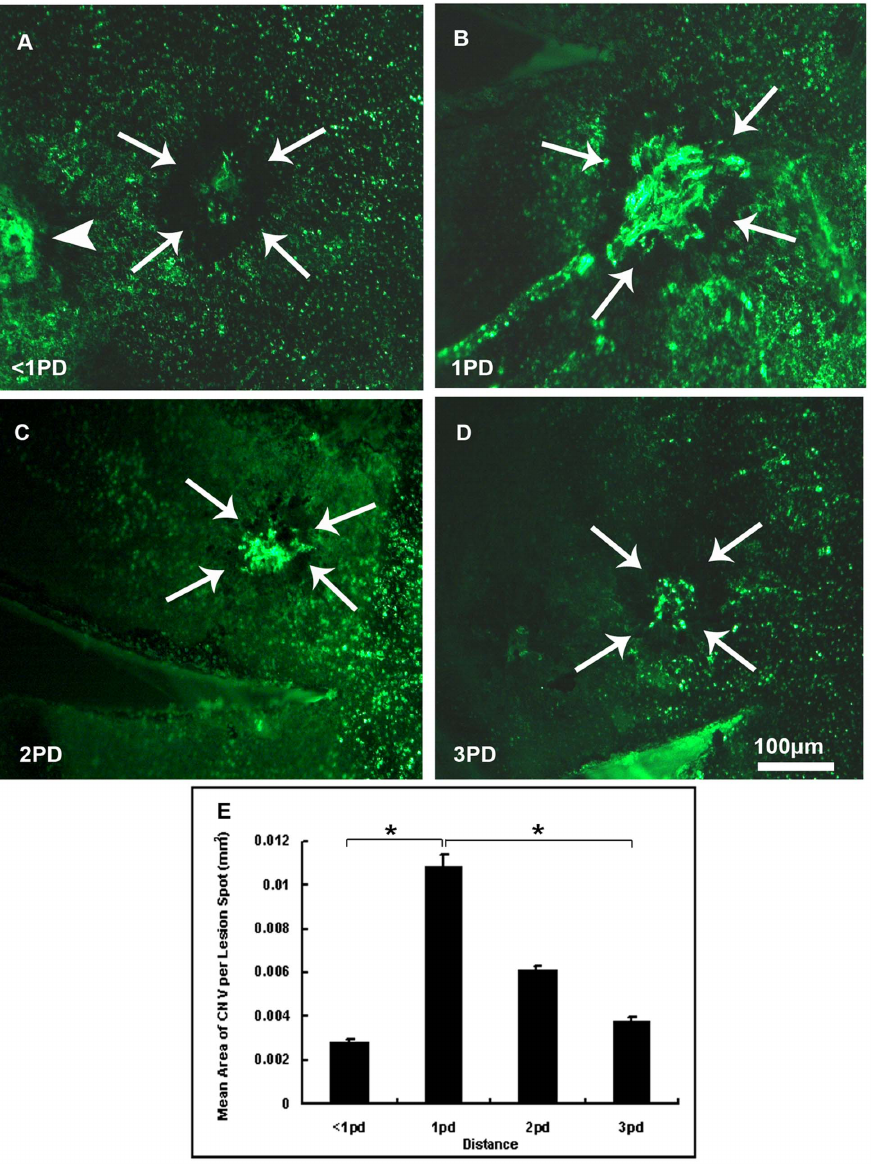
Figure 6. Mean area of CNV of laser spots delivered with different distances away from the optic disc. CNV area of spots delivered with distance of , 1PD, 1PD 2PD and 3PD away from optic disc was examined.16–20 week-old female C57BL/6 mice were given laser photocoagulation spots at 3, 12 and 9 o’clock positions in the retinas with distance of , 1PD (A), 1PD (B), 2PD (C), or 3PD (D) away from the optic disc of each eye with a cover slide placed on the cornea as a contact lens. After two weeks, eyes were enucleated after perfusion with fluorescein-labeled dextran and choroidal flat mounts were examined by fluorescence microscopy. The area of CNV of each spot was measured by image analysis and the mean ( 6 SEM) area of CNV of each group was calculated with the investigator masked with respect to the experimental groups. Significant difference was observed among these four groups. It was shown that significantly more CNV area (0.0109 6 0.0005 mm 2 ) appeared in spots 1PD away from the optic disc (P=0.008), while 0.0028 6 0.0002 mm 2 in spots , 1PD (arrow head showed the adjacent optic disc in Figure 6A)away from the optic disc and 0.0038 6 0.0001 mm 2 in spots 3PD away from the optic disc (Fig. 6E). The mean CNV area tended to decrease as spots became farther away from the optic disc. But there was no significant difference of mean CNV area between 2PD-away spots and 1PD, , 1PD, or 3PD-away spots. Statistical significance was analyzed by one-way ANOVA. The arrow head shows the optic disc. (n=5mice/group, *P , 0.01).